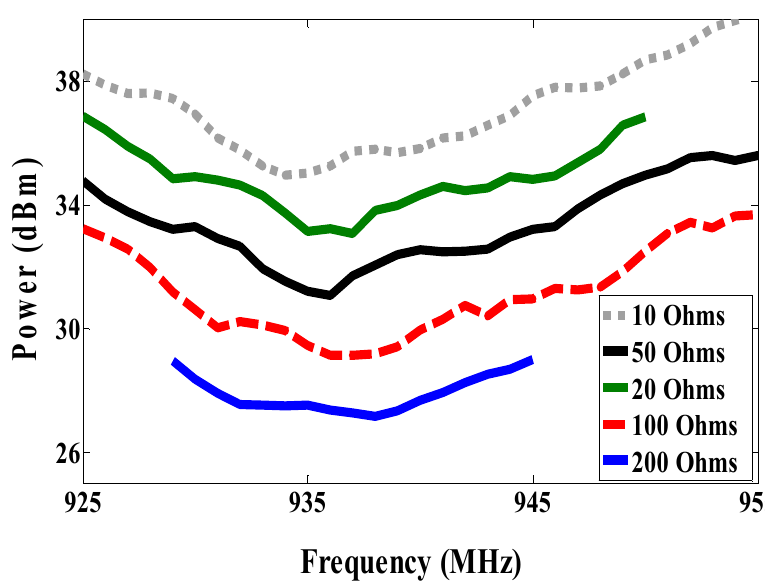
Figure 14. Measured minimum power required to activate sensor node with di ff erent resistance (antenna